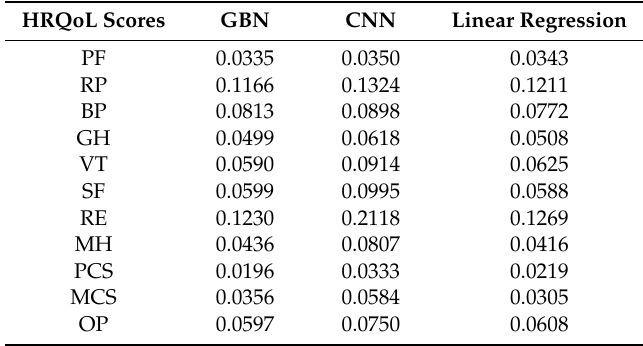
Table 2. Mean squared errors of the GBN, the CNN, and the multivariable linear regression model. HRQoL Scores GBN CNN Linear Regression